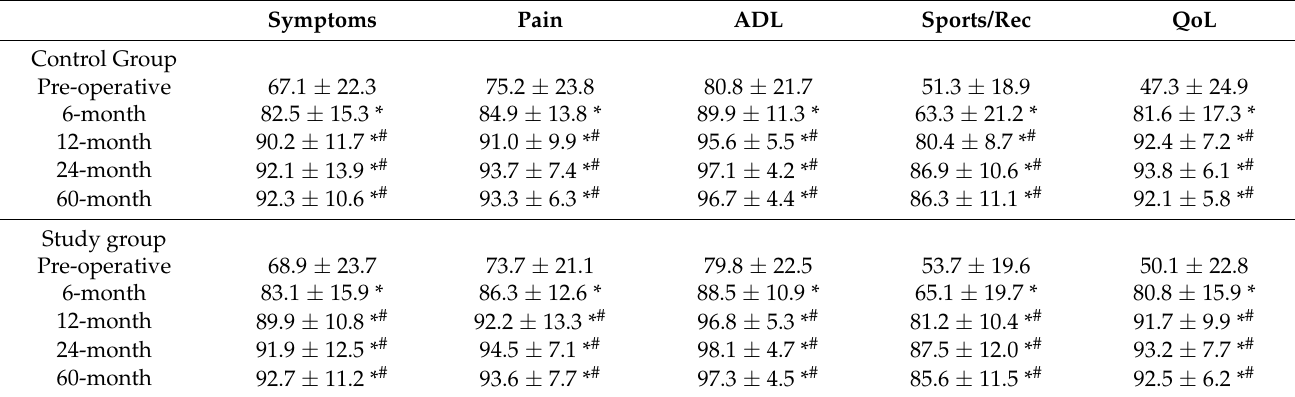
Table 1. KOOS Outcomes in the Study and Control Groups a